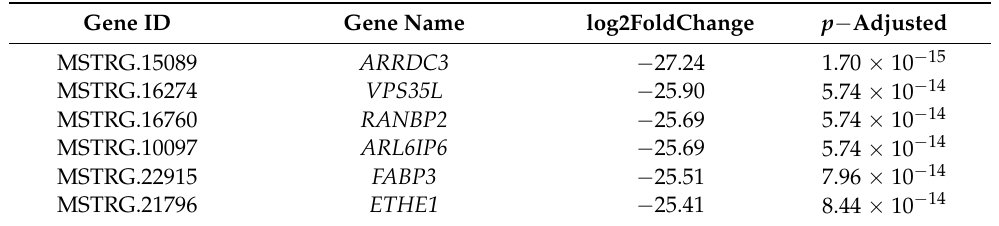
Table 3. Significantly downregulated differentially expressed genes (DEGs) between RTX-treated (RTX) and control (CTR)